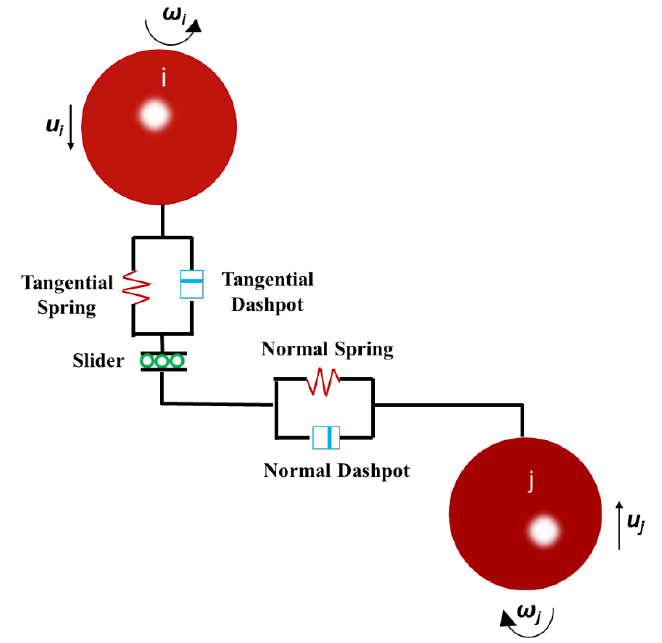
Figure 2. Depiction of forces acting particle i in contact with particle j . Table 1. Detailed description of the parameter expressions in discrete element method